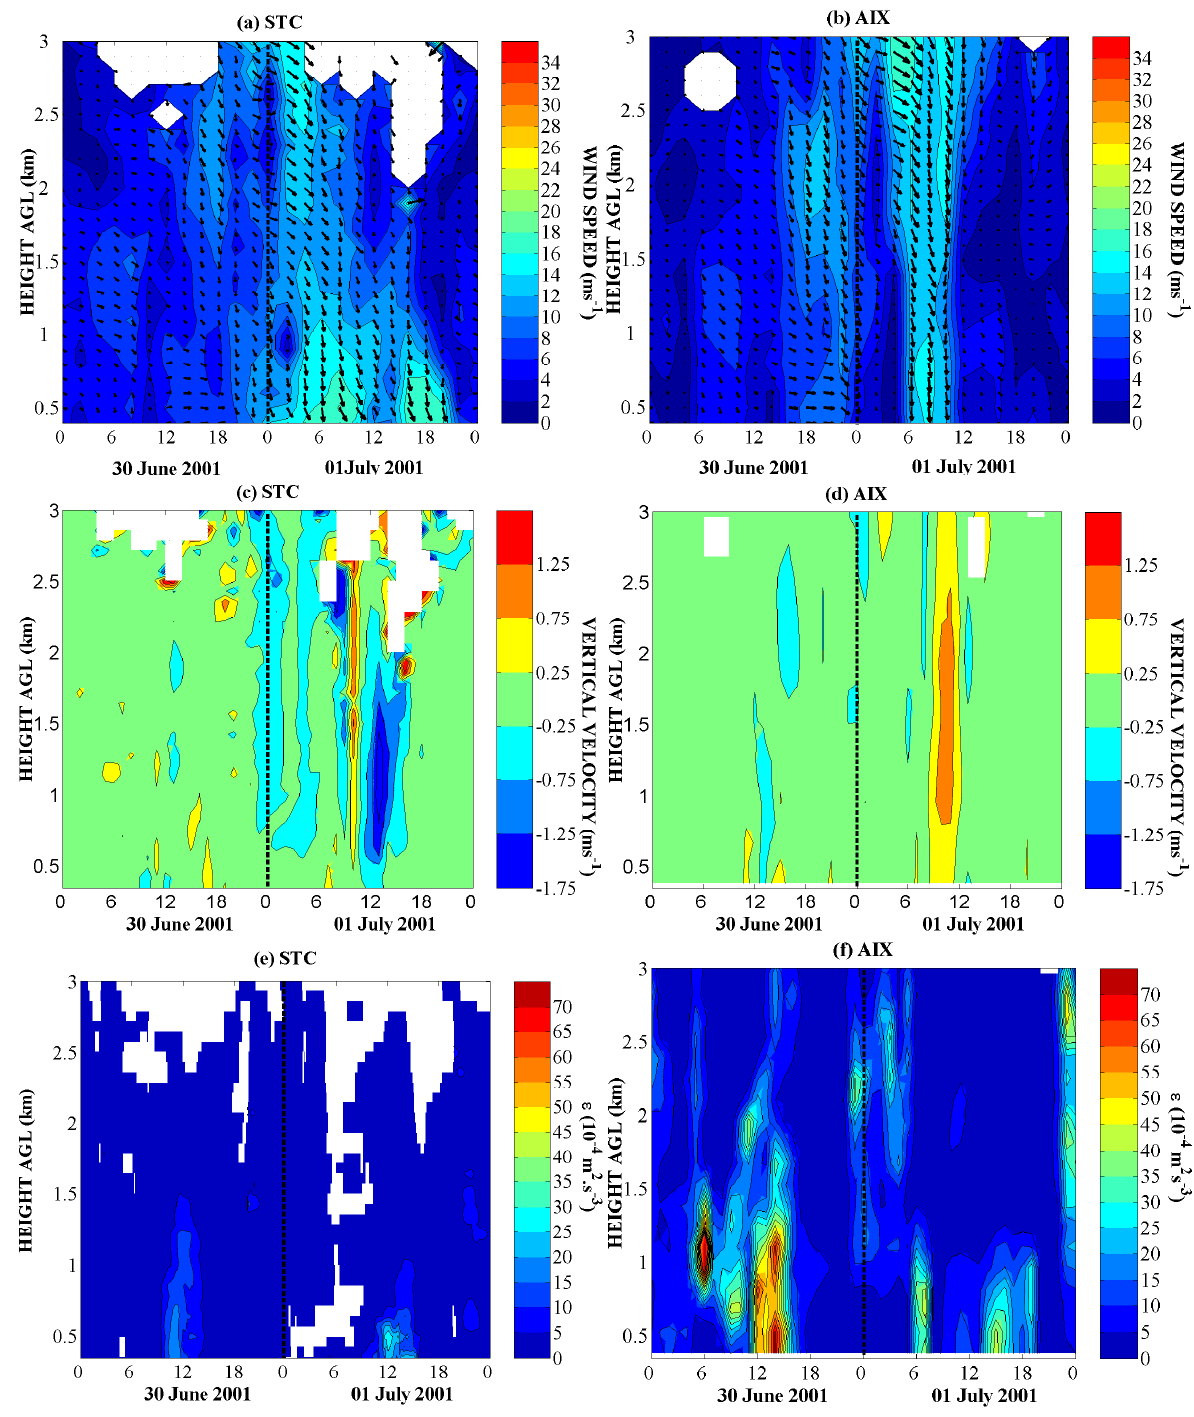
Fig. 5. Same as Fig. 3, at STC ( a , c , e ) and AIX ( b , d , f ) , during the 30 June–1 July Mistral event (from the ESCOMPTE Special Observing